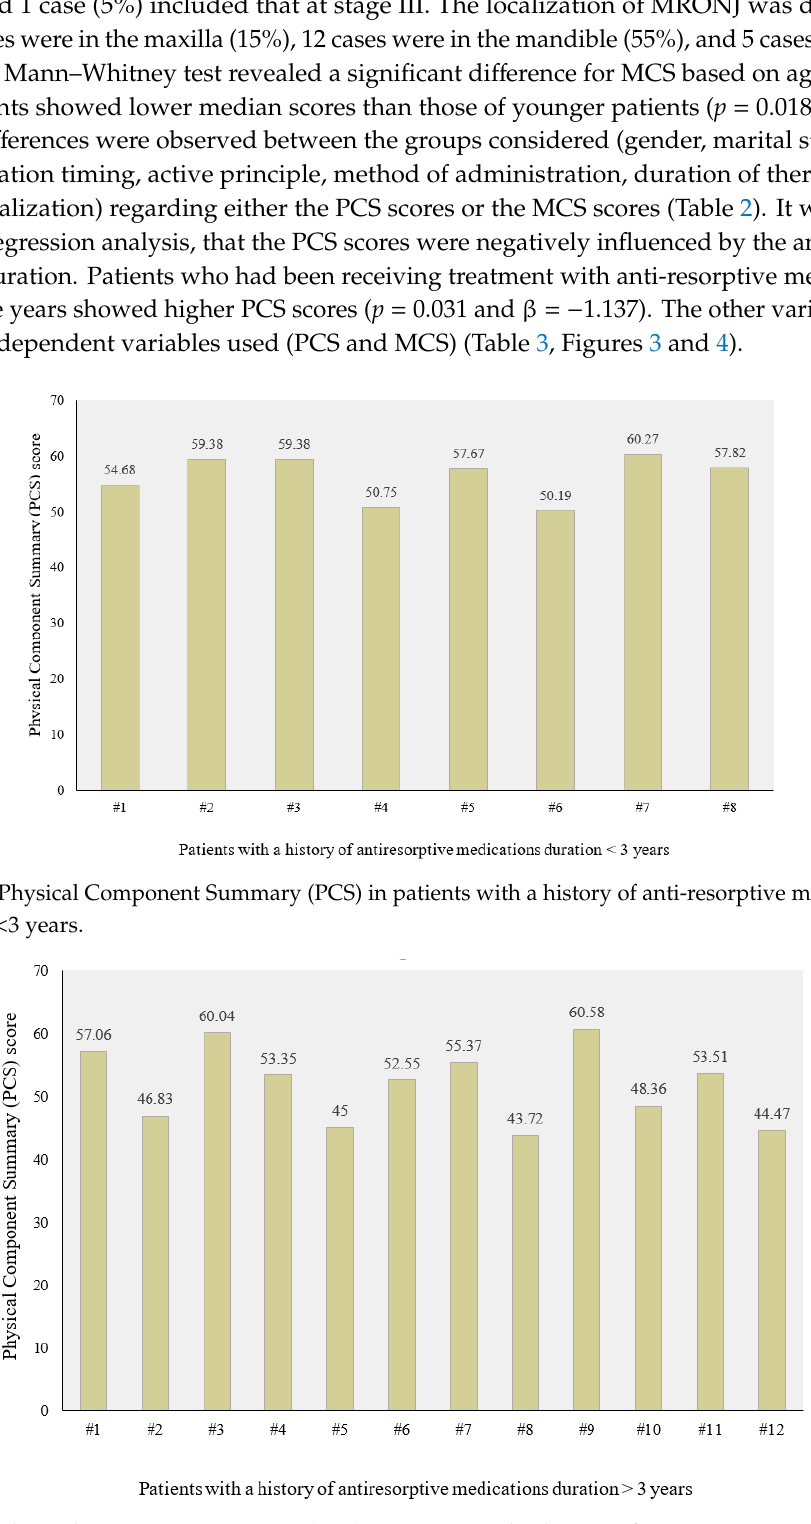
Figure 2. Mental Component Summary (MCS) histogram (created by SPSS software for Windows, release 20.0).